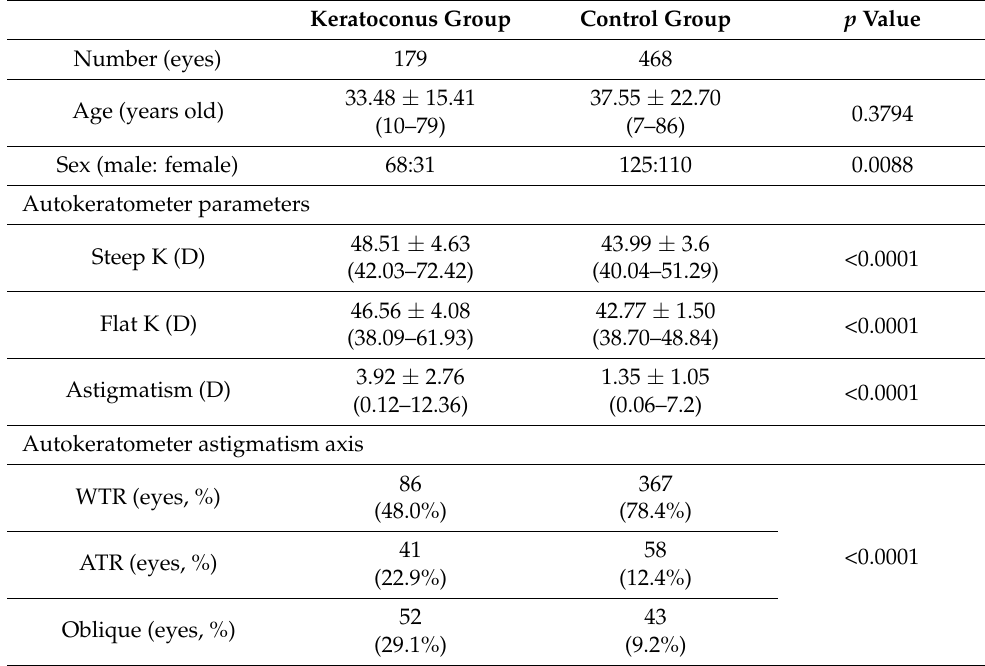
Table 1. Control subjects and keratoconus patients demographic information.